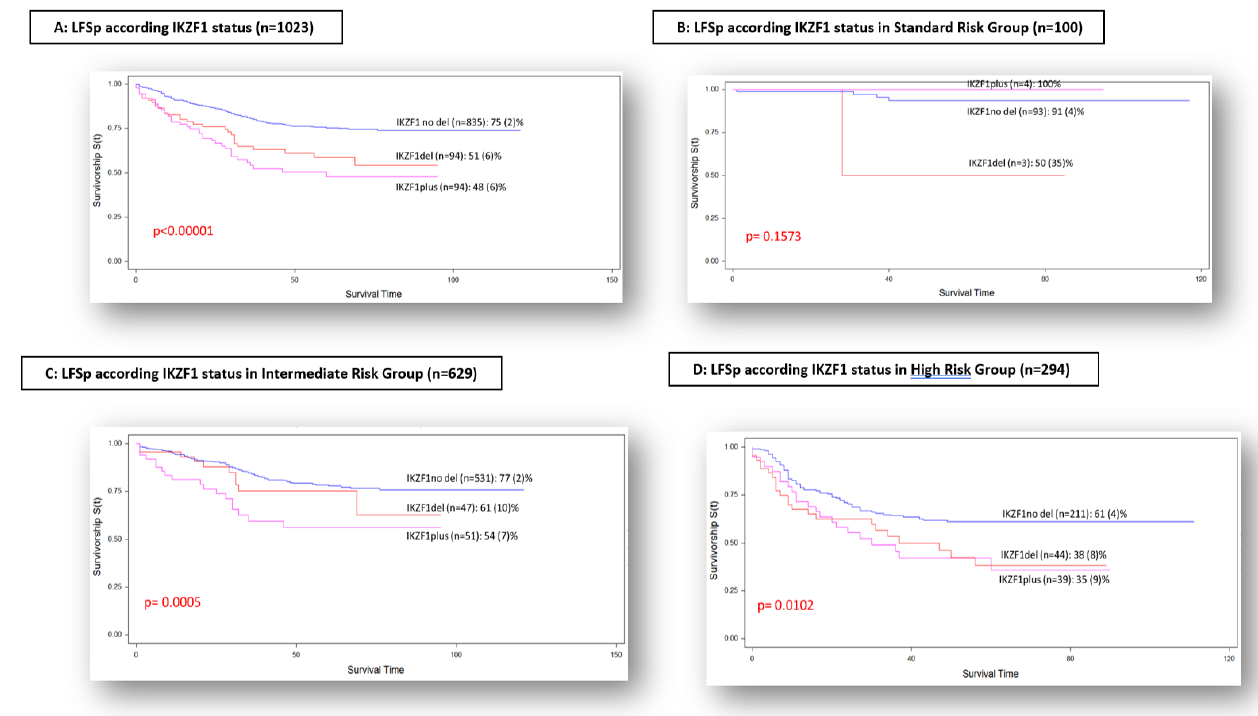
Figure 1. LFS probability according to IKZF1 status and according to risk-group stratification. The LFSp (SE) according to risk groups was: in SRG, 91 (4)% for IKZF1not-del, 50 (35)% for IKZF1del and 100% for IKZF1plus ( p -value = ns) (Figure 1B); in IRG, 77 (2)% for IKZF1not-del, 61 (10)% for IKZF1del and 54 (7)% for IKZF1plus ( p -value = 0.0005) (Figure 1C); and in HRG, 61 (4)% for IKZF1not-del, 38 (8)% for IKZF1del and 35 (9)% for IKZF1plus ( p -value = 0.0102) (Figure 1D). When we compared the outcome of the different IKZF1 subsets according to MRD results on day 33, a statistically significant difference was observed between the three groups in the population of patients with negative MRD, the LFSp (SE) being 79 (2)% for IKZF1not-del, 62 (9)% for IKZF1del and 56 (7)% for IKZF1plus ( p -value = 0.0003) (Figure 2A). In the group of patients with positive MRD at that time-point, LFSp (SE) was 50 (6)% for IKZF1not-del, 41 (9)% for IKZF1del and 38 (3)% for IKZF1plus, respectively ( p -value = 0.3192) (Figure